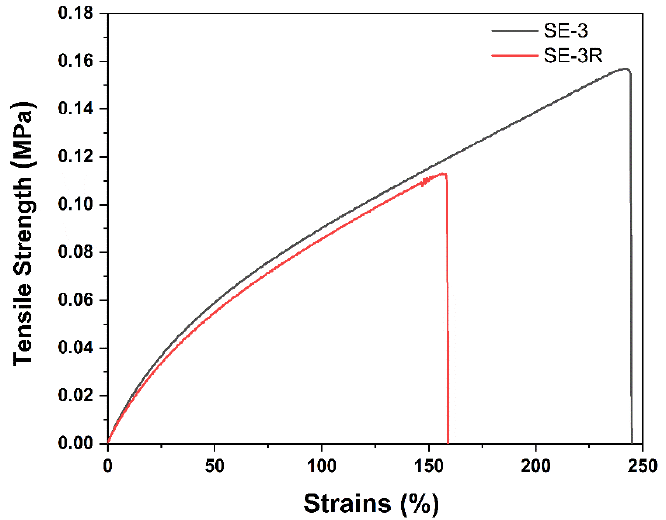
Figure 7. Stress-strain curves before and after self-healing of SE-3. SE-3R represents the elastomer after